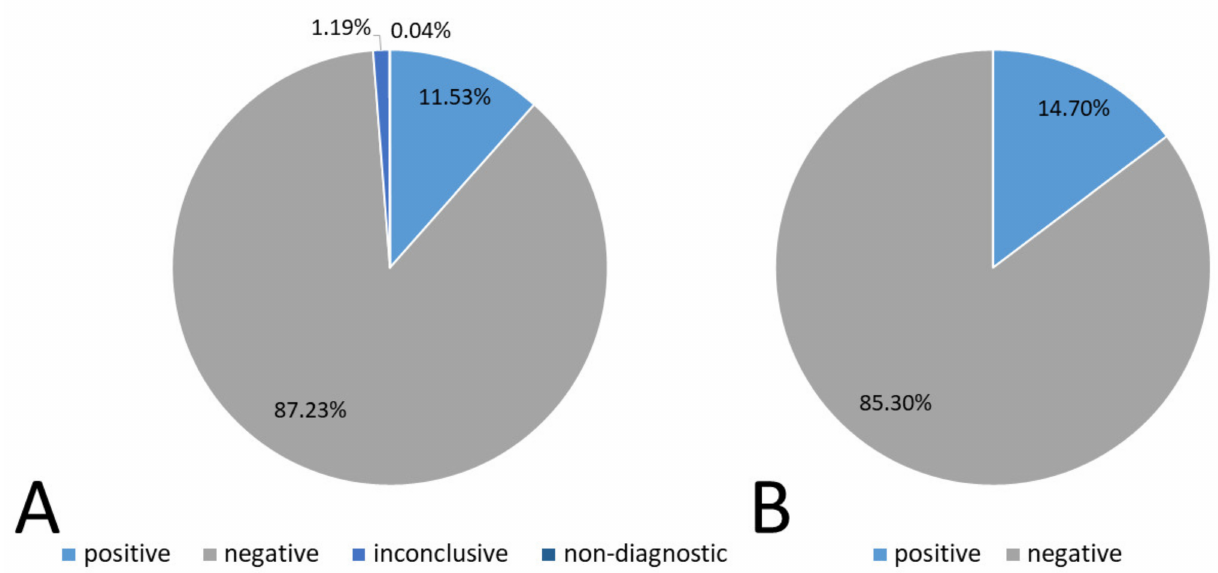
Figure 1. Total tests results including inconclusive and non-diagnostic results ( A ). Prevalence of SARS-CoV-2 infection in the examined population ( B